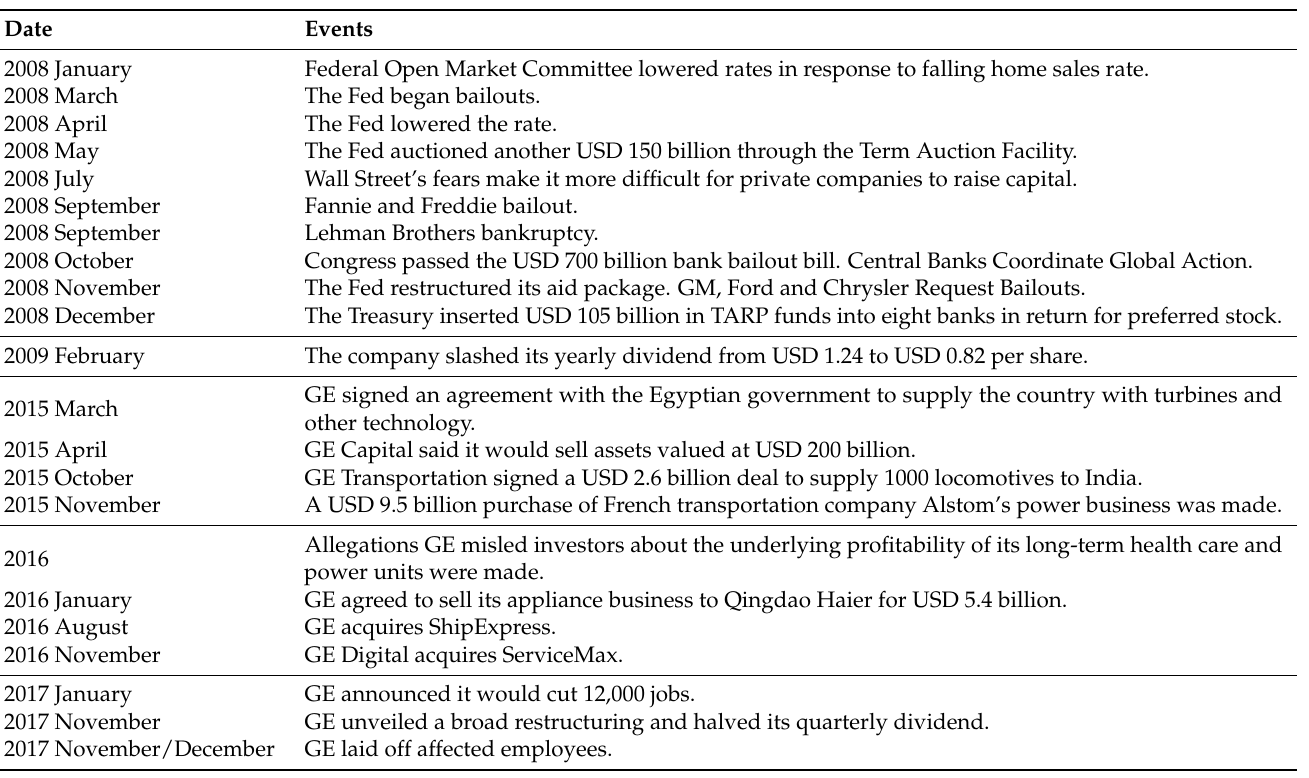
Table 3. Publicly available events that may influence the value of General Electric